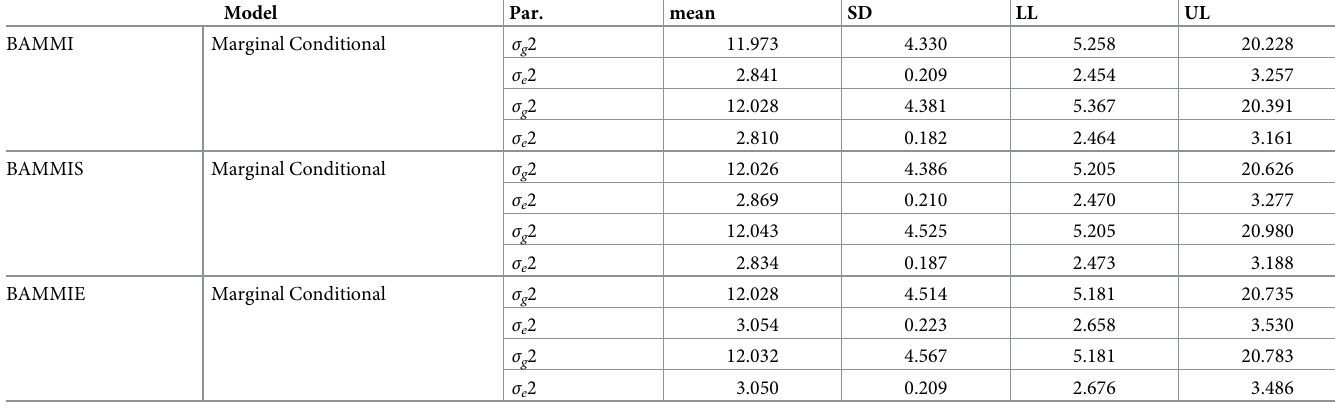
Table 3. Posterior means the standard deviation (SD) and the 95% HPD intervals (LL: lower limit, LU: upper limit) for components of variance genotypic ( σ g 2 ) and residual ( σ e 2 ) for models with conditional and response responses.